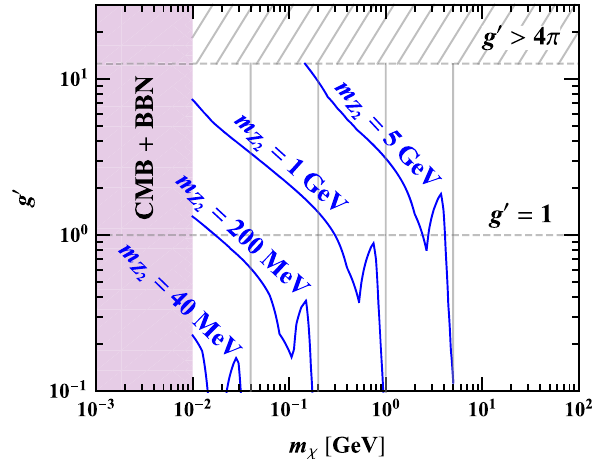
Fig. 11 Values of the DM mass m χ and the coupling g (cid:9) required to = 0 . 04, reproduce the observed relic abundance. We have fixed m Z 2 0 . 2, 1, and 5 GeV, and have considered the representative case of θ = 0 . 031, while keeping θ μ,τ = 0. Along (above) the blue lines e the DM relic density matches (is less than) the observed value. We do not consider m χ > m Z to ensure the neutrino portal regime. The lower 2 bound m χ (cid:3) 10 MeV is set by observations of the CMB and